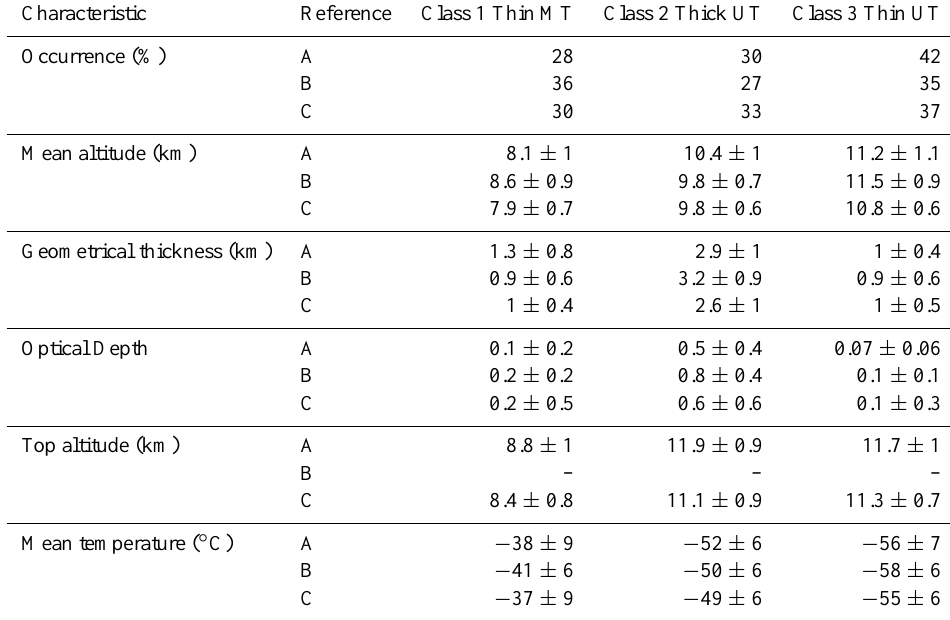
Table 1. Characteristics of the different classes identified over the Observatory of Haute Provence (OHP) site. Class 1 to 3 represent re- spectively thin cirrus in the middle troposphere (Thin MT), thick cirrus in the upper troposphere (Thick UT) and thin cirrus in the upper troposphere (Thin UT). The references A, B and C correspond respectively to the update analyses (1996–2007), the analyses performed by Keckhut et al. (2006) over the year 2000 and in using the CALIPSO data up to now (2006–2012).